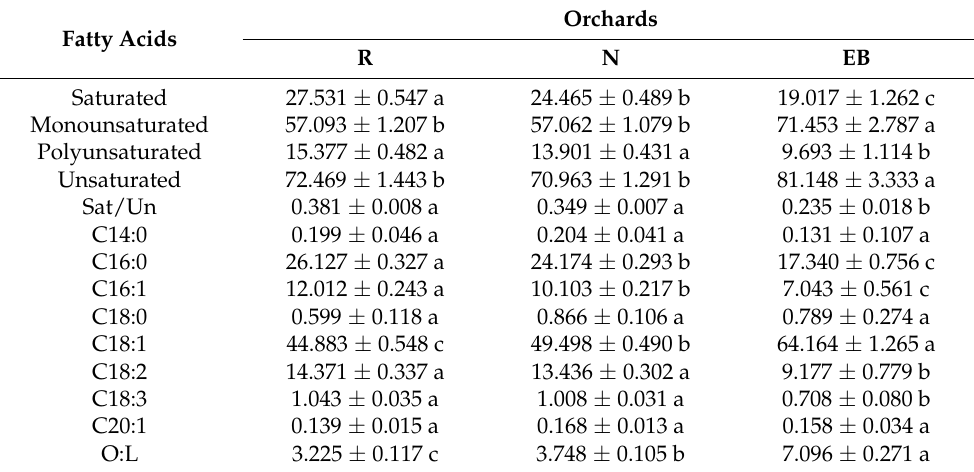
Table 2. Composition of fatty acids (% fatty acids on the total fatty acid methyl ester—FAMEs— content) in the three localities